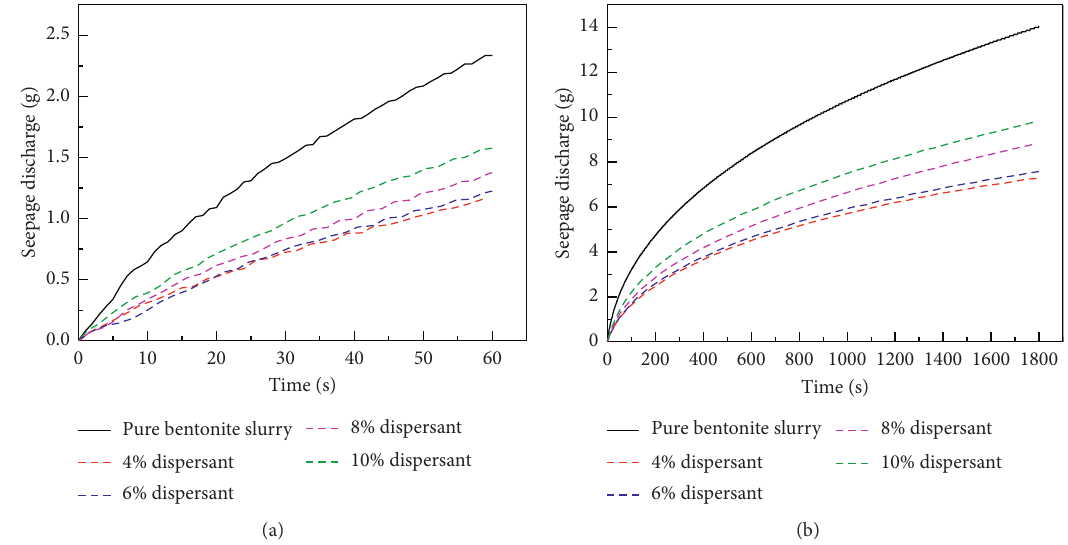
Figure 7: Seepage discharge during filter cake formation after (a) 60s and (b) 30 min.